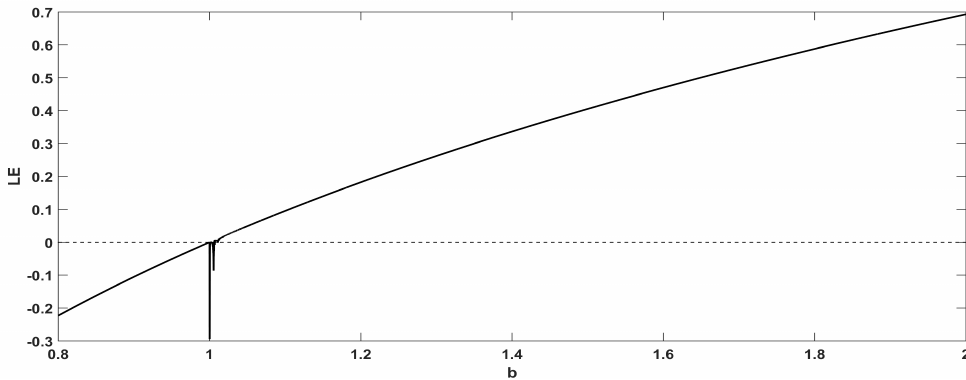
Figure 8. LE diagram with respect to parameter b , for a = 1, r = 1.